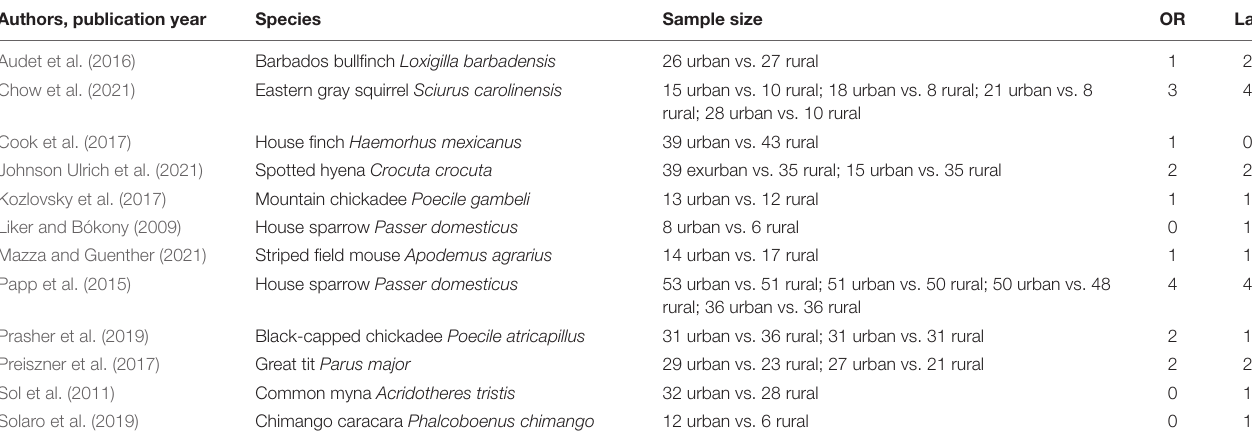
TABLE 1 | List of papers included, with study species, sample size [flocks in Liker and Bókony (2009); pairs in Preiszner et al. (2017); individuals in every other study], and number of solving success odds ratios (OR) and solving latencies (Lat) collected from the study.